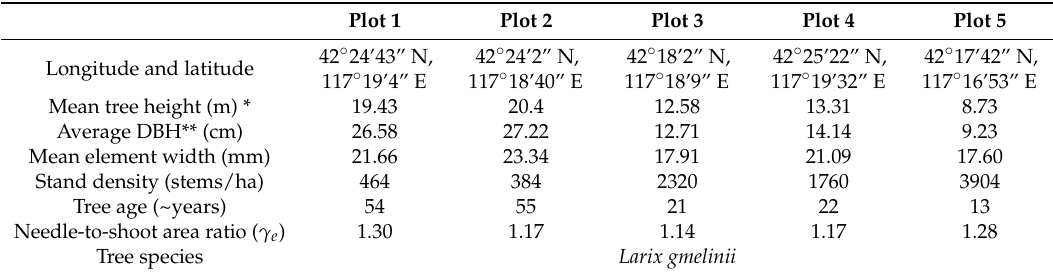
Table 2. Characteristics of Larix gmelinii Rupr.